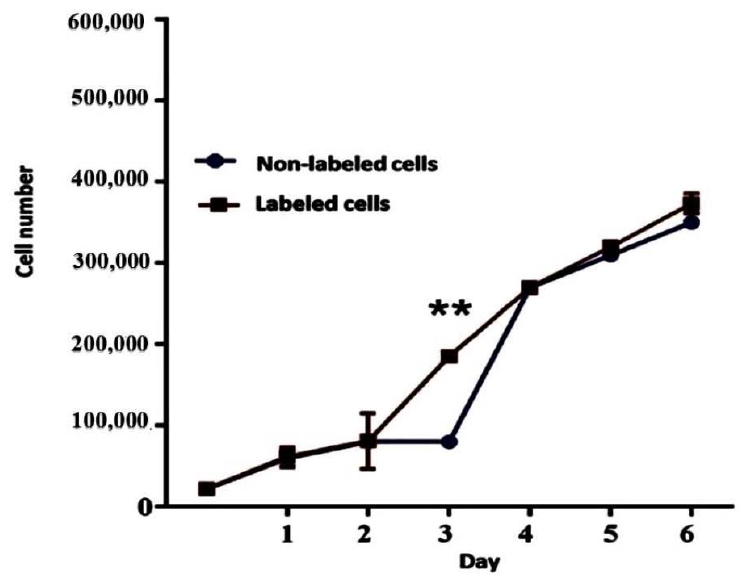
Figure 3. The population doubling time (PDT) in an hour and the growth curve were determined until day 6. The number of cells treated with 180 µg/mL of iron oxide transfected with 1 µL/mL of lipofectamine (Day 1: p = 0.92, day 2: p = 0.97, day 3: ** p = 0.0001, day 4: p = 0.95, day 5: p = 0.28, day 6: p = 0.155), revealing the PDT of 36 h and 33 h for non-labeled and iron oxide labeled cells (180 µg/mL) transfected with 1 µL/mL lipofectamine, respectively.